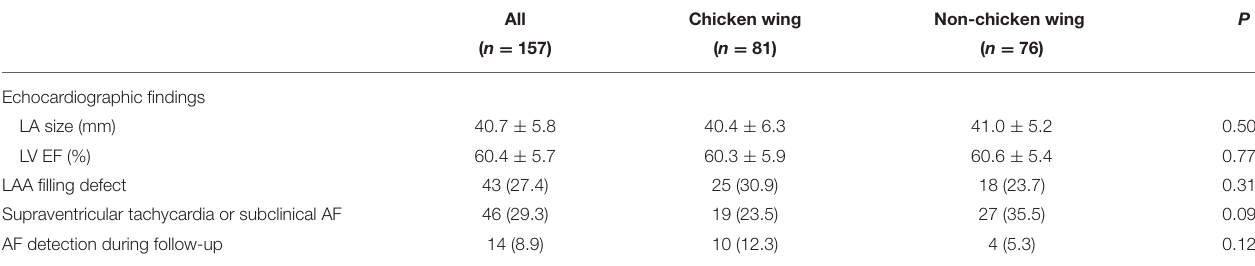
TABLE 2 | Comparisons of cardiac markers between patients with and without chicken wing left atrial appendage morphology. All Chicken wing Non-chicken wing